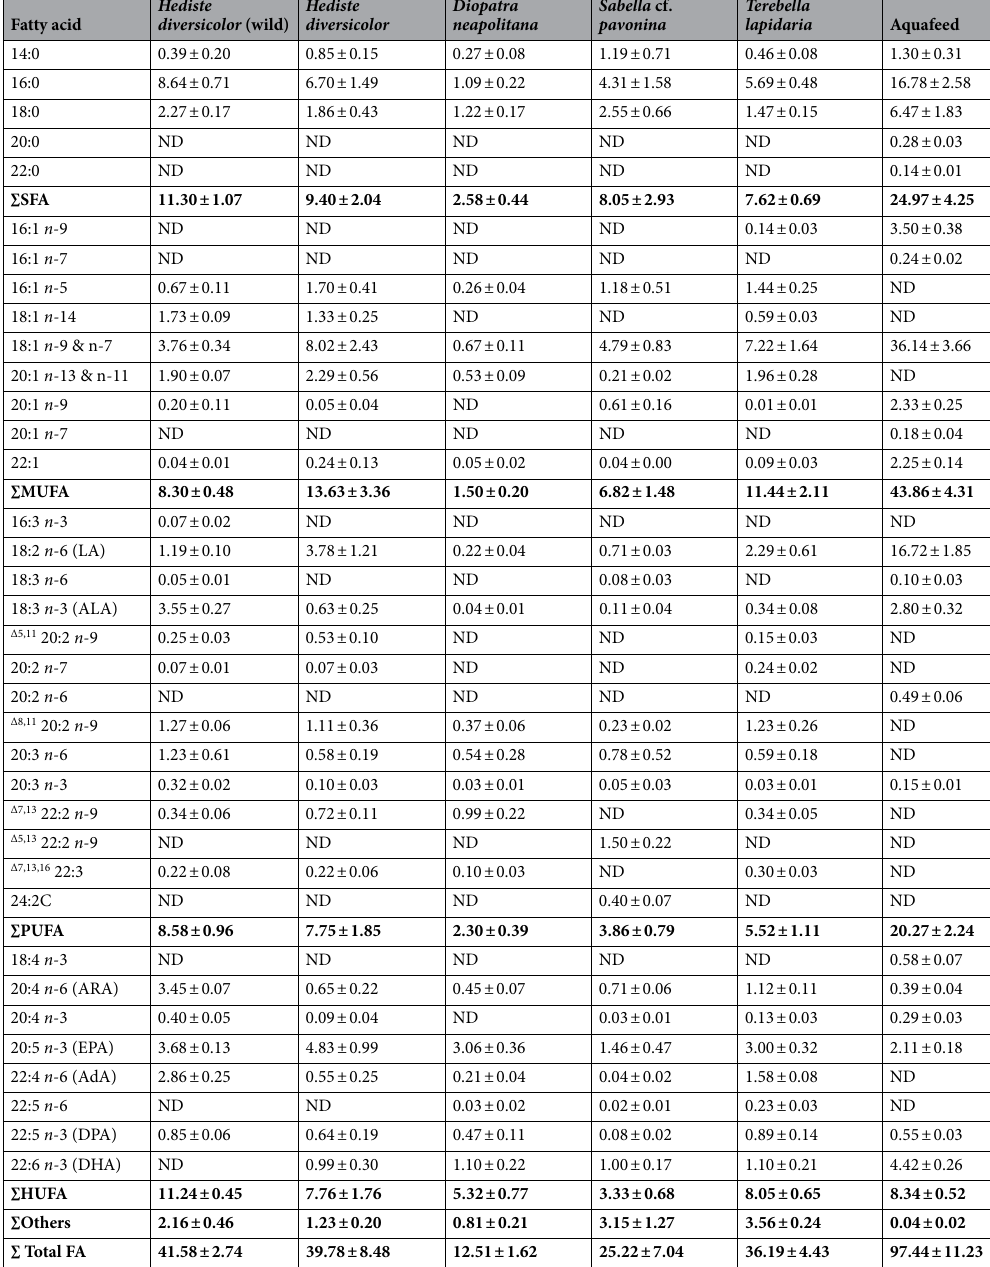
Table 1. Fatty acid composition (µg mg −1 DW) of wild and IMTA-cultured polychaete species and aquafeed added to fish. Average values ± (SD). The bold values represent the sum (∑) of SFA saturated FA, MUFA mono-unsaturated FA, PUFA polyunsaturated FA, HUFA highly unsaturated FA, Other—FA identified from microbiome and iso and anteiso (Supplementary Table S1) and total FA. AdA adrenic acid, ALA alpha-linolenic acid, ARA arachidonic acid, DHA docosahexaenoic acid, DPA docosapentaenoic acid, EPA eicosapentaenoic acid, LA linoleic acid. ND—FA not detected. PUFA defined as all FA with ≥ 2 double bonds and HUFA all FA with ≥ 4 double bonds (not considered within